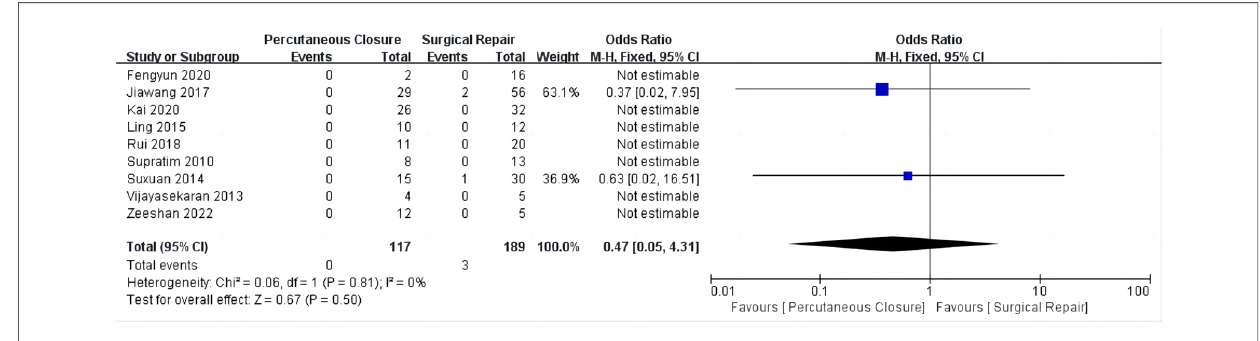
FIGURE 2 Comparison of in-hospital mortality between percutaneous closure and surgical